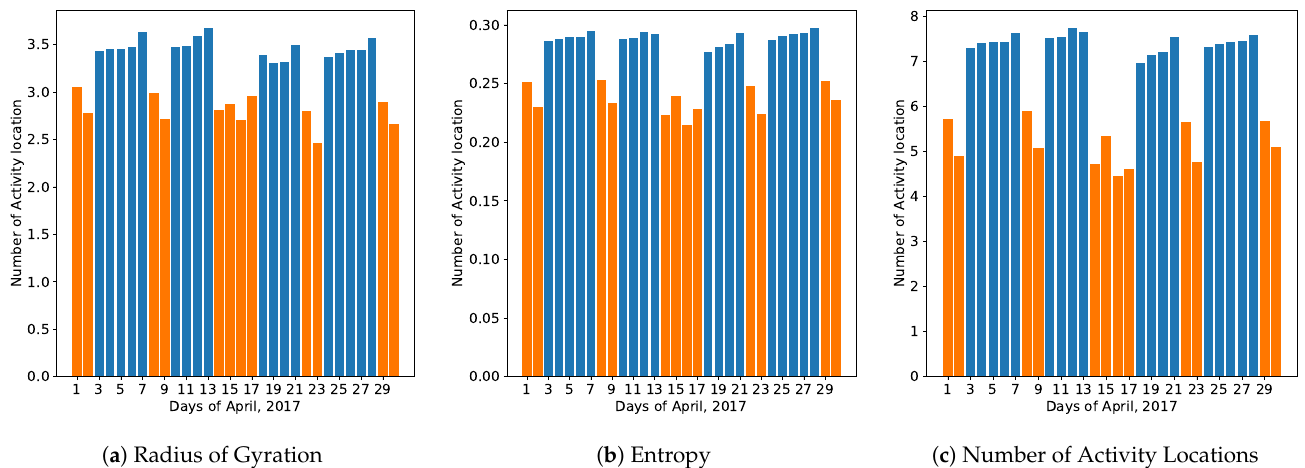
Figure 12. The differences between workdays (blue) and holidays (orange) are clear. Orange columns represent the holidays, 14 April 2017 was Good Friday and 17 April 2017 was Easter Monday that are holidays in